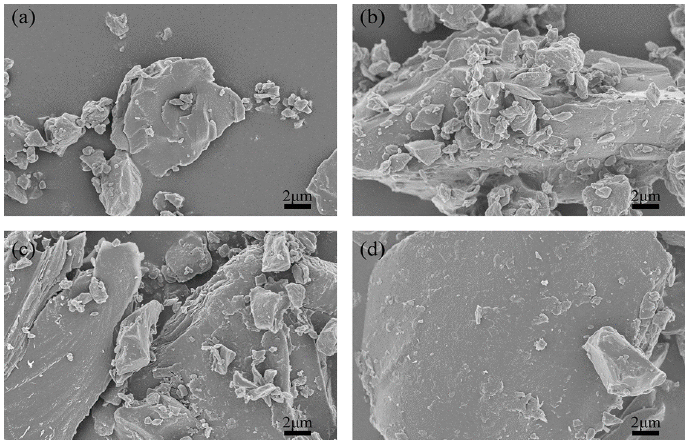
Figure 1. Effect of N-doped temperature on material’s optimization: ( a ) green petroleum coke, ( b ) nitrogen-doped graphene-like plates (N-GLPs) 350 2 , ( c ) N-GLPs 550 2 , and ( d ) N-GLPs 750 2 . XRD